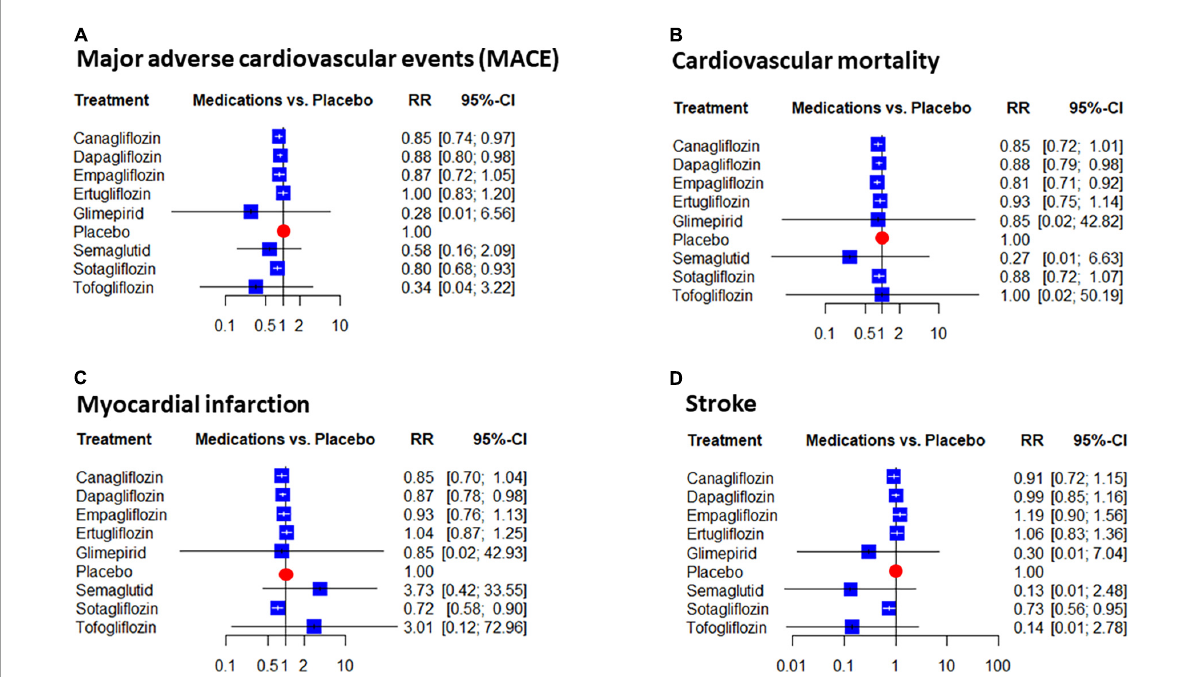
FIGURE4 Network estimates of placebo compared the effect on the risk of major adverse cardiovascular events (MACE): Forest plots show the relative risk (RR) values and their 95% confidence intervals of individual treatments as estimated on MACE (A) and its components: Cardiovascular mortality (B) , myocardial infarction (C) , stroke (D) .